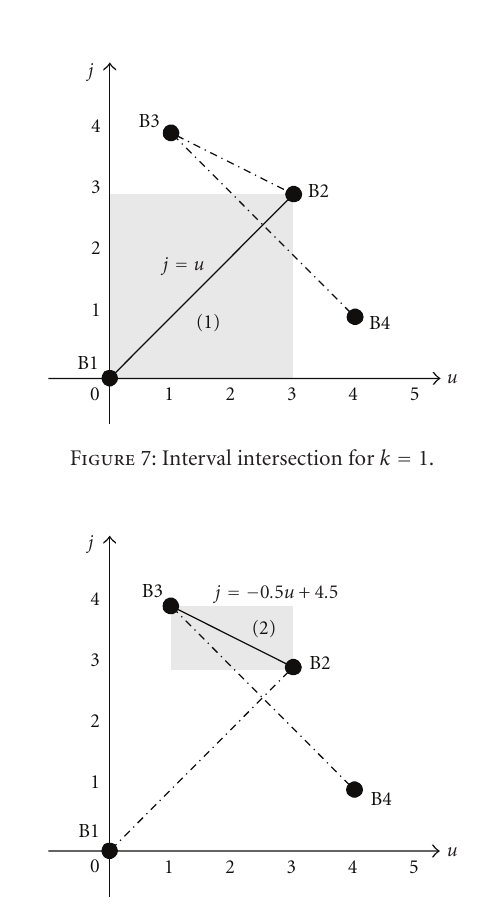
Figure 8: Interval intersection for k = 2.